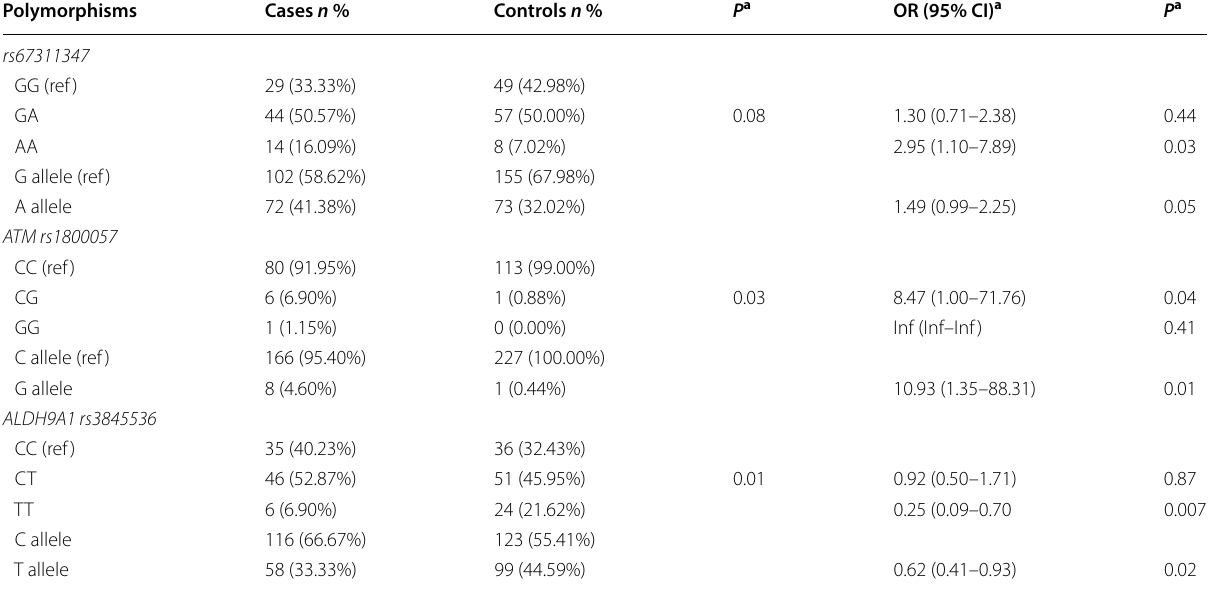
Table 3 Association between SNPs rs67311347 , ATM rs1800057 and ALDH9A1 rs3845536 and risk of RCC